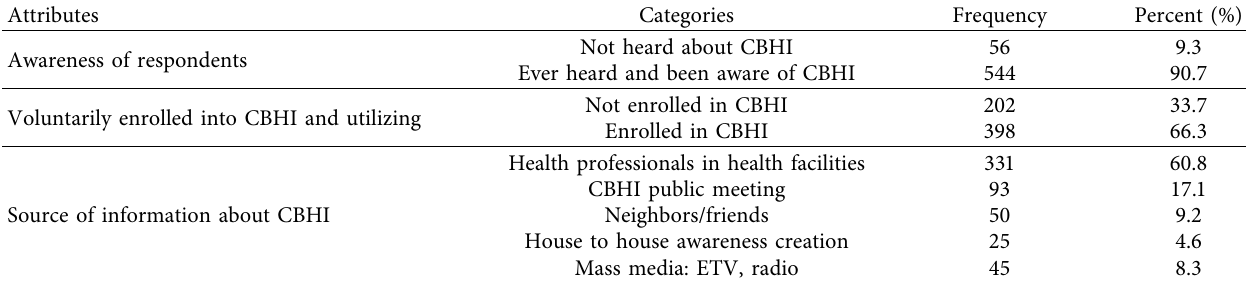
Table 2: Awareness and willingness of respondents to join CBHI, Akaki District,